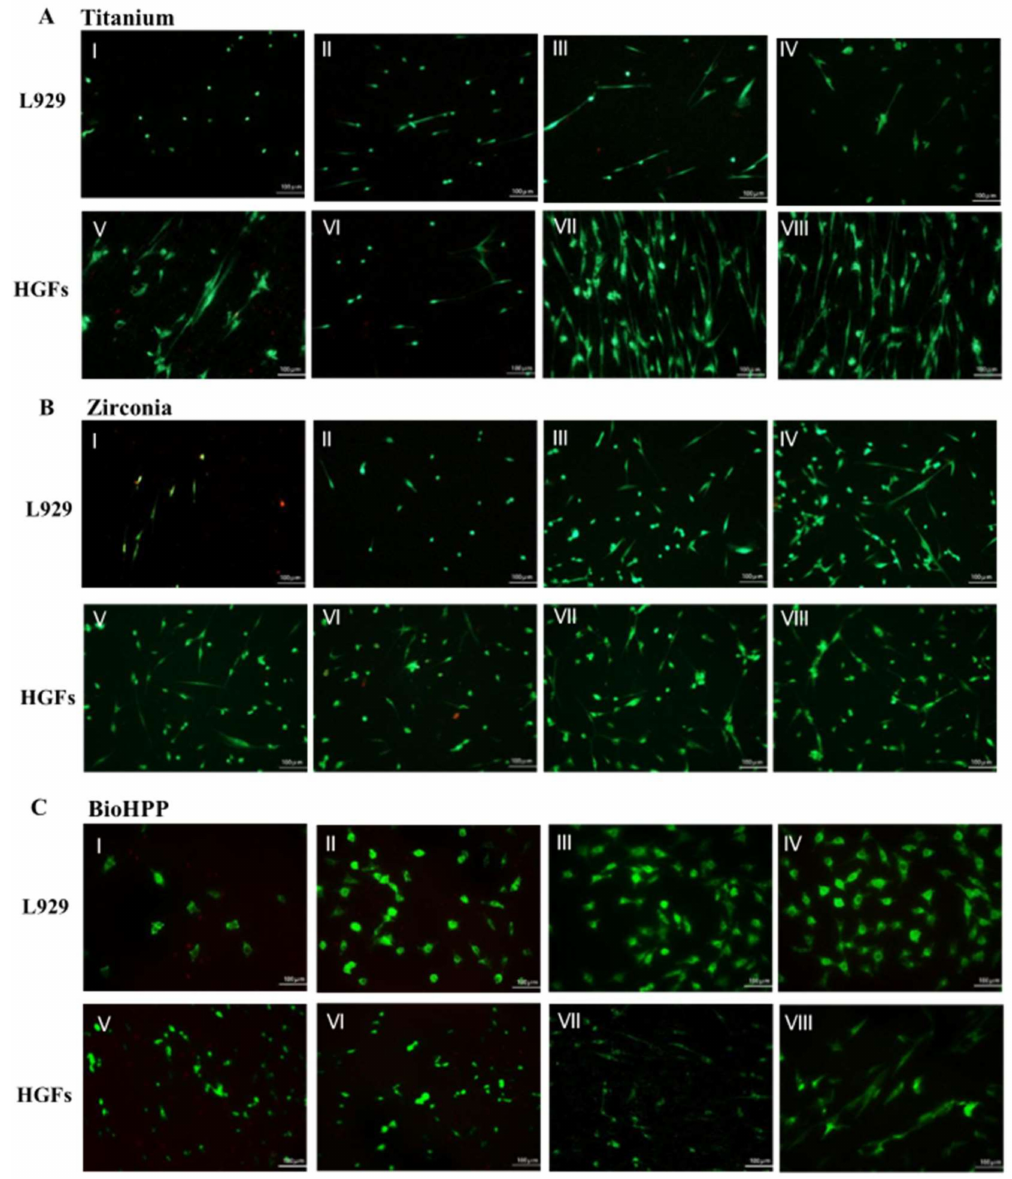
Figure A2. Cell attachment and morphology on di ff erent surface-treated titanium, zirconia and BioHPP after 48